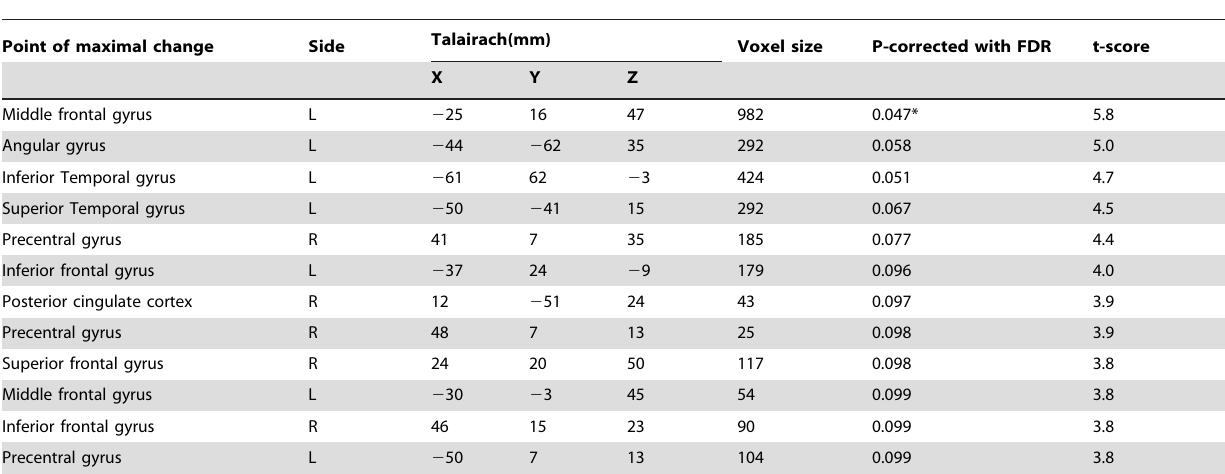
Table 1. VBM analysis revealed decreased gray matter volume in MCI group compared to controls.